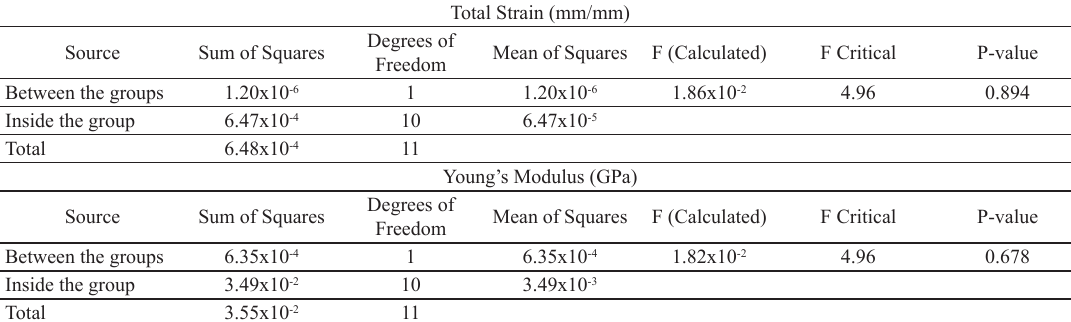
Table 5. Analysis of variance for composites with red mud.